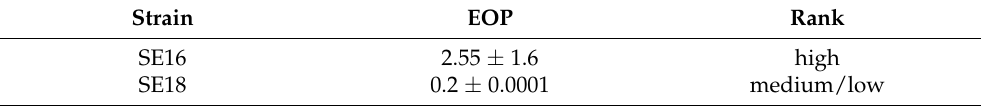
Table 1. Efficiency of plating (EOP) of CUB-EPI_14 phage dilutions against target bacteria. EOP values were determined using SE14 as reference strain. Values are expressed as average ± SD.